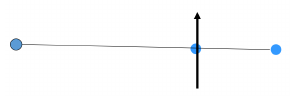
Fig. 9. One body crosses the line connecting two distant bodies.